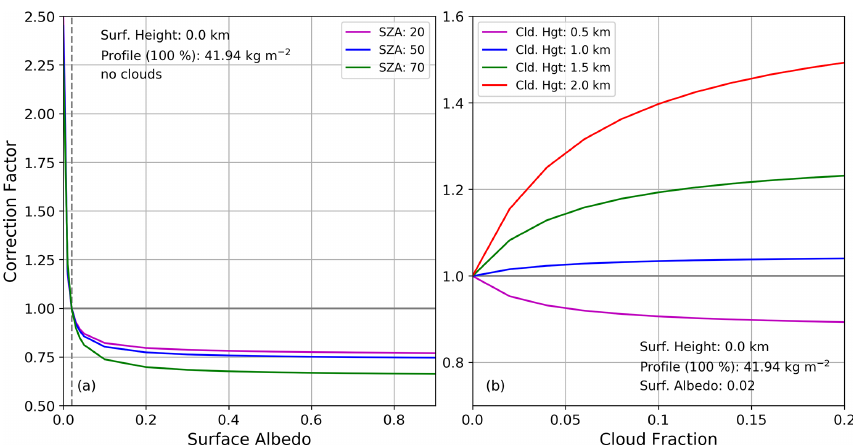
Figure 3. (a) Correction factor as a function of surface albedo for various solar zenith angles. (b) Correction factor as a function of cloud fraction for various cloud